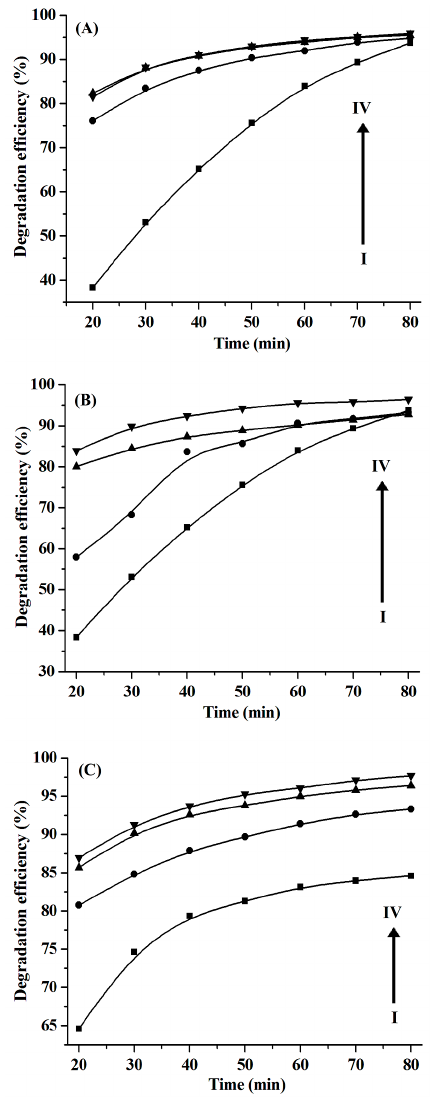
Figure 8. The influence of H 2 O 2 dosage on the degradation efficiency of the RhB catalyzed by CuS prepared from di ff erent systems. ( A ) [C 4 C 2 OOHim]NTf 2 / Na 2 S system, ( B ) [C 4 C 2 OOHim]NTf 2 /